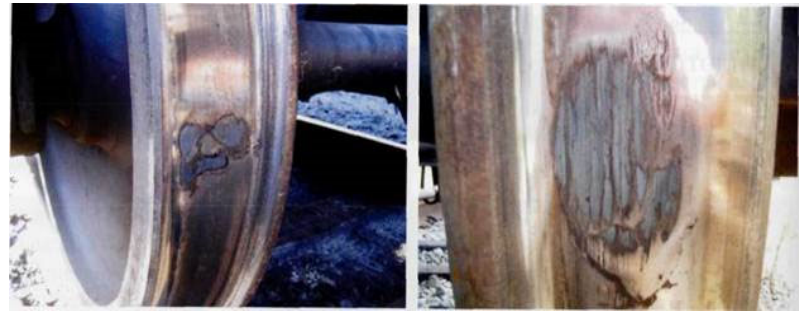
Figure 3. Sample of wagon wheel damage—flat.